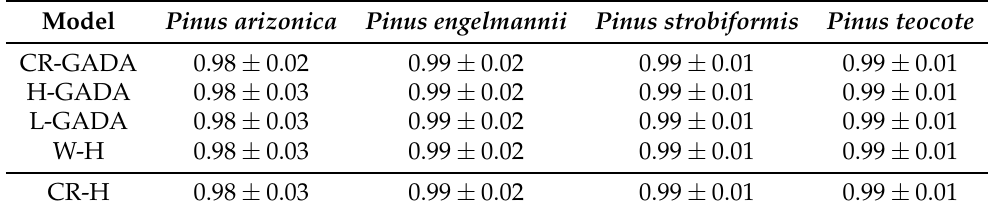
Table 6. R 2 and respective standard deviation results for each species and model in the study. Model